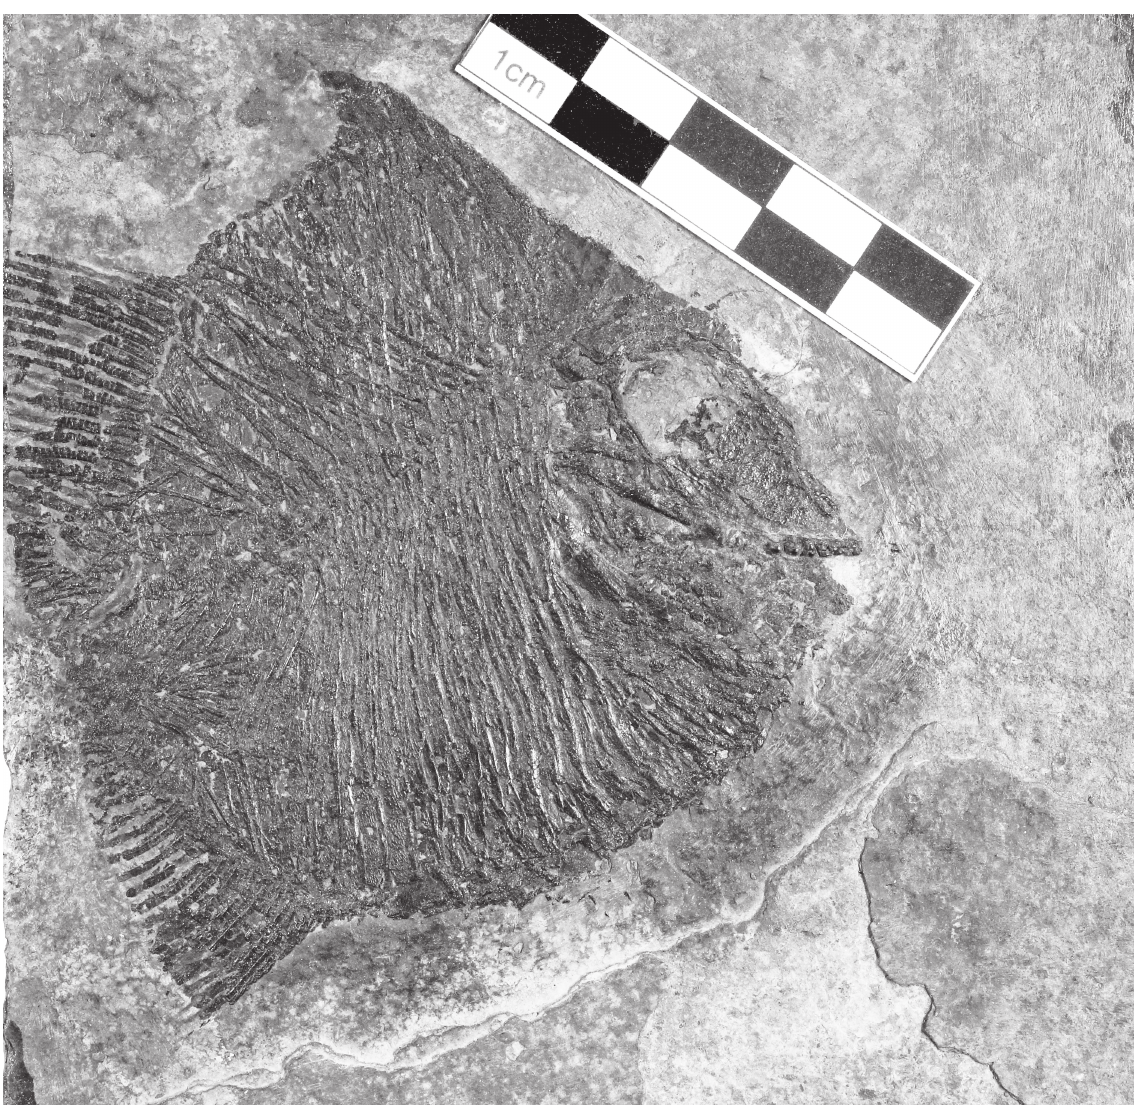
Fig. 20. Brembodus ridens Tintori, 1980. Sample CLC J-420 from Zogno, Zorzino Formation, Upper Norian (Late Triassic),